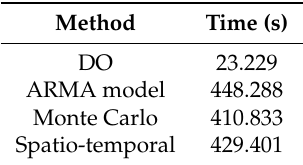
Table 10. The computation time of the methods.